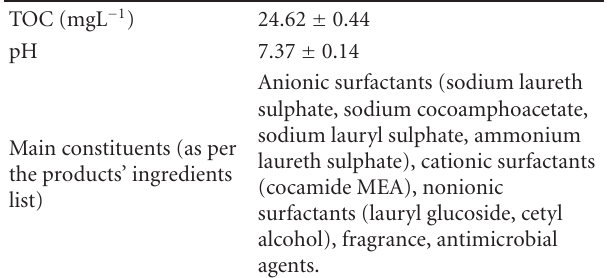
Table 1: Shower water